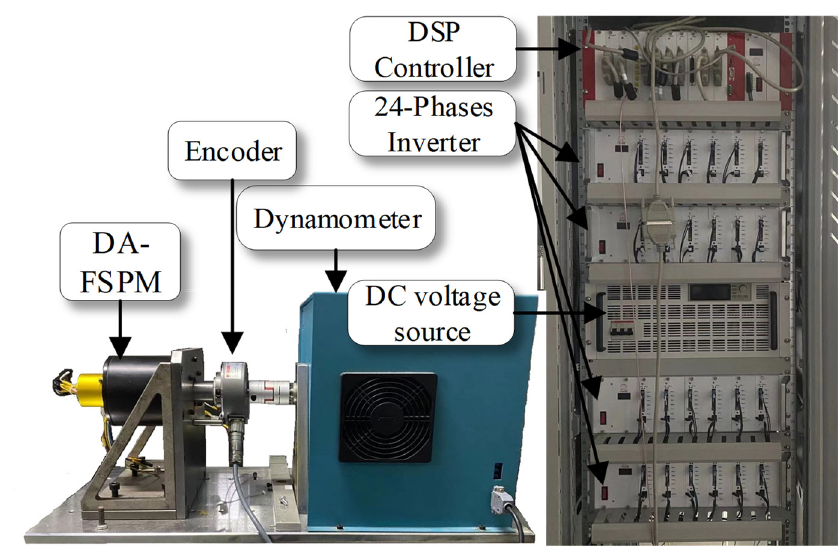
Figure 9. The test platform of the DA-FSPM prototype.